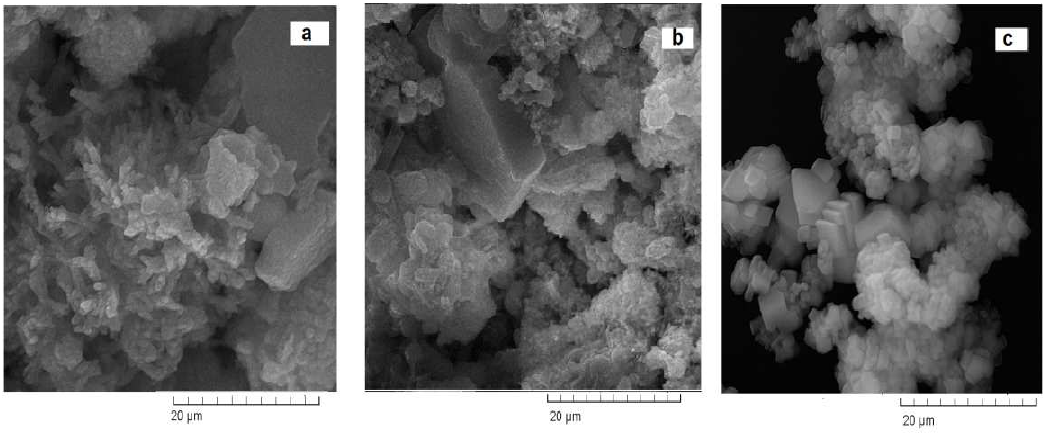
Figure 4. SEM images of PCC ( a ), PCC/1% polyDADMAC ( b ) and PCC/0.1% cPAM ( c ) saples .